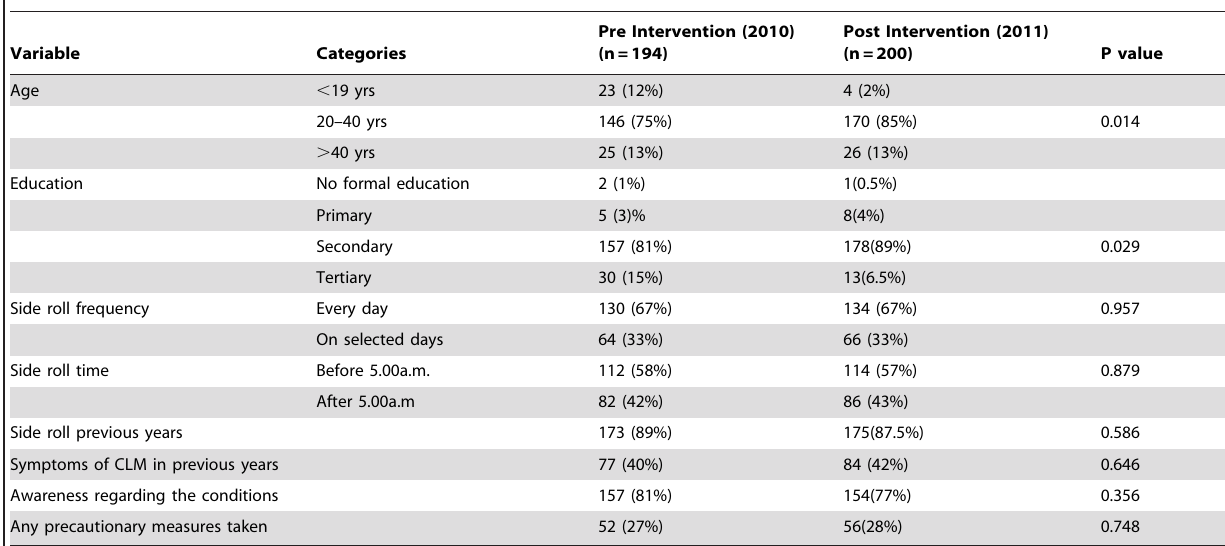
Table 1. Comparison of study population before and after intervention.